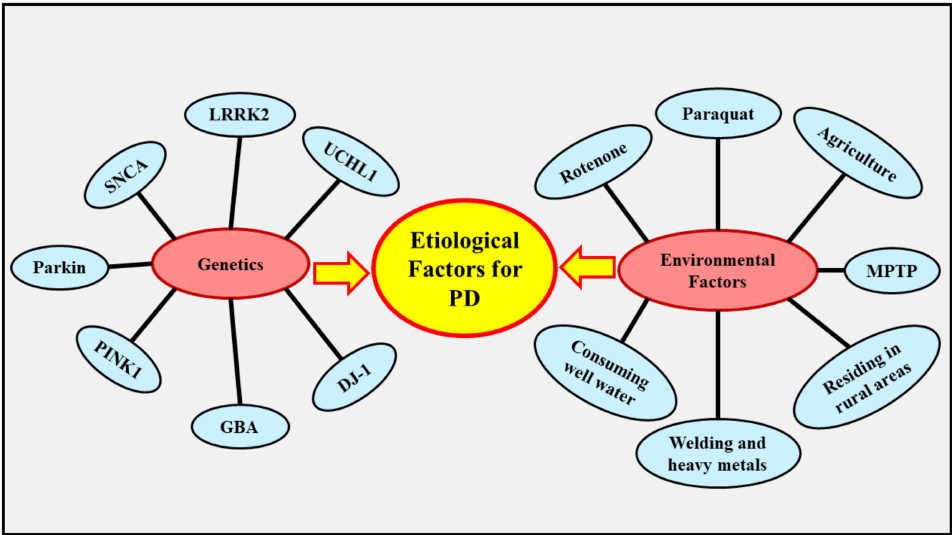
Figure 2. Etiological factors for Parkinson’s disease. UCHL1, ubiquitin C-terminal hydrolase L1; LRRK2, leucine-rich repeat kinase 2; SNCA, α -synuclein; Parkin, Parkin RBR E3 ubiquitin-protein ligase; PINK1, PTEN-induced kinase 1; GBA, glucocerebrosidase; DJ-1, protein deglycase; PD, Parkinson’s disease; MPTP,